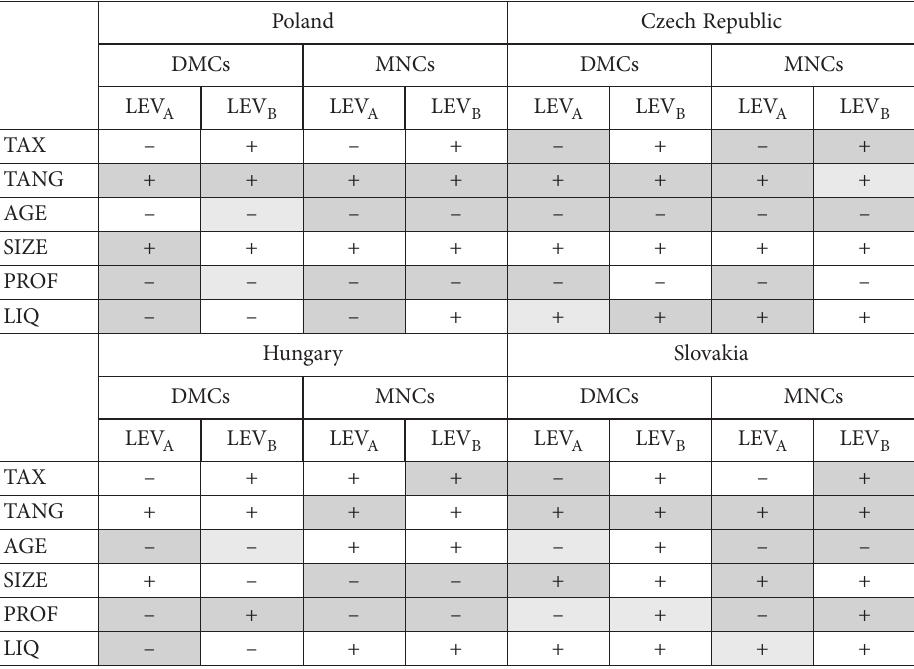
Table 12. Summary of data panel